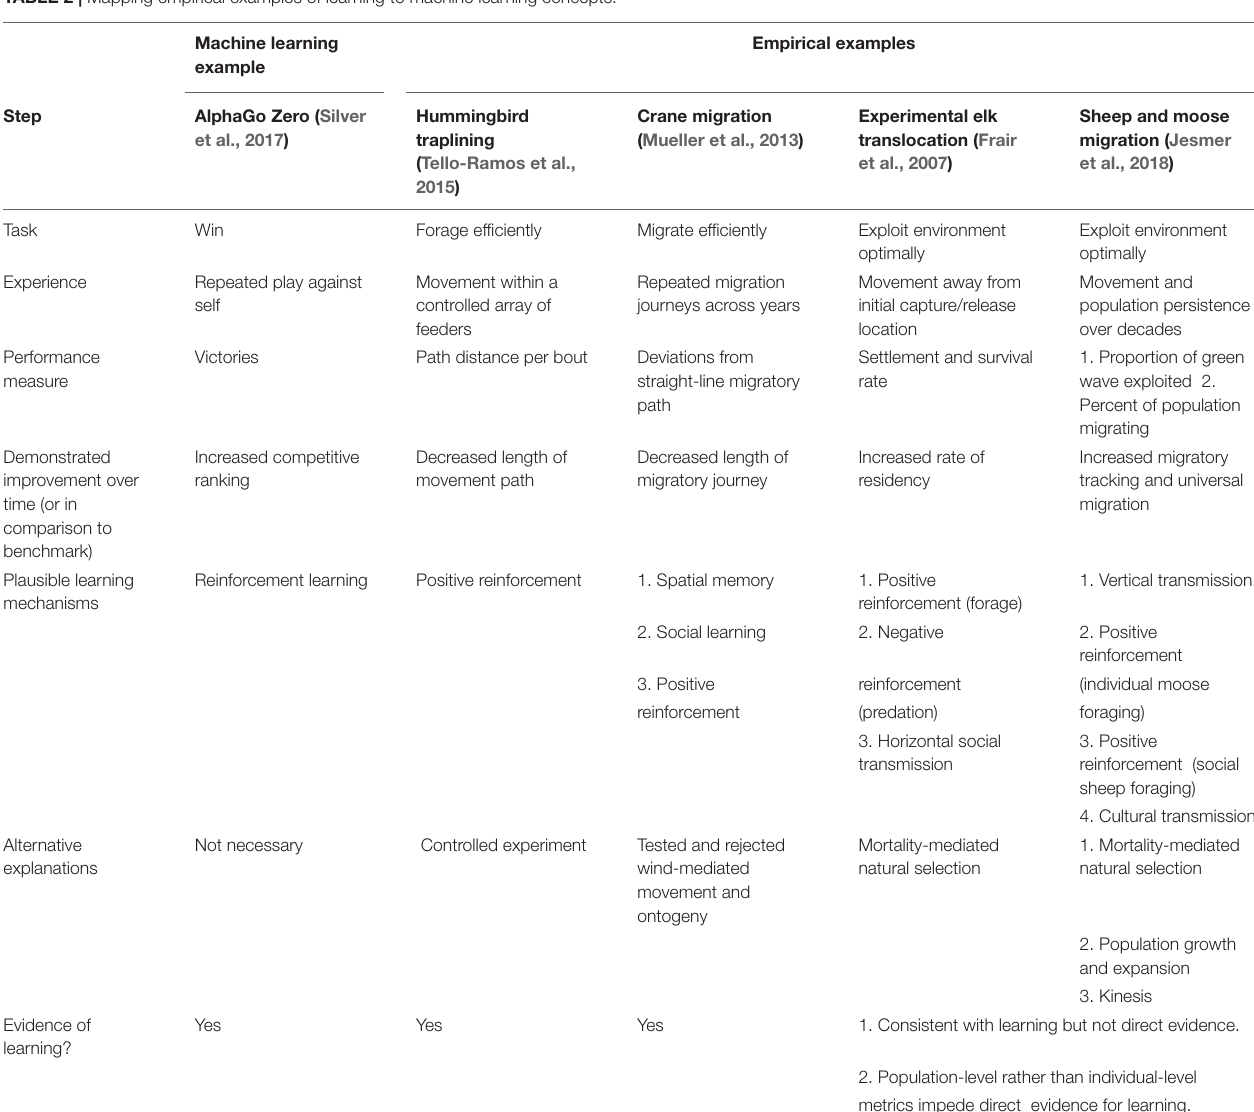
TABLE 2 | Mapping empirical examples of learning to machine learning